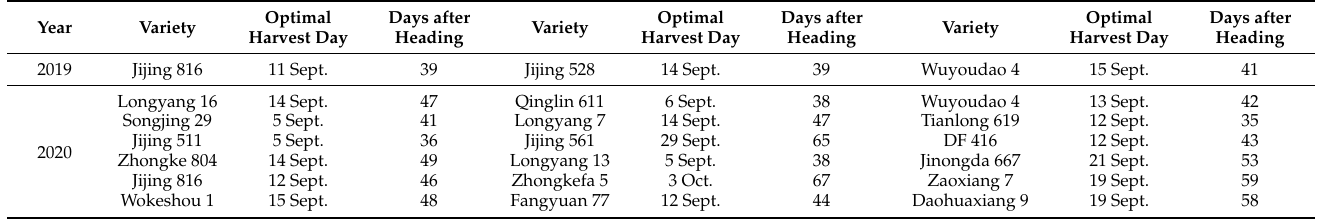
Table 3. Optimal harvest days of rice and the number of days after heading in 2019 and